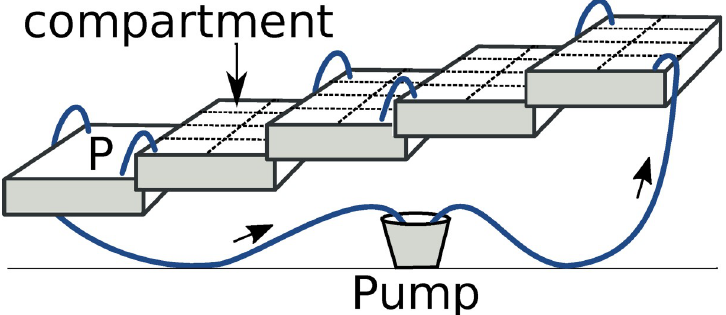
Fig 1. Schematic of one gravity flow circuit. At the start of the experiment, each of the 32 compartments contained 10 hatchlings from a single family. A dragonfly was regularly fed non-experimental tadpoles in the bottom tub (P) so that chemical predation cues were present throughout tadpole development. Blue lines indicate silicone tubing and arrows show the direction of flow.